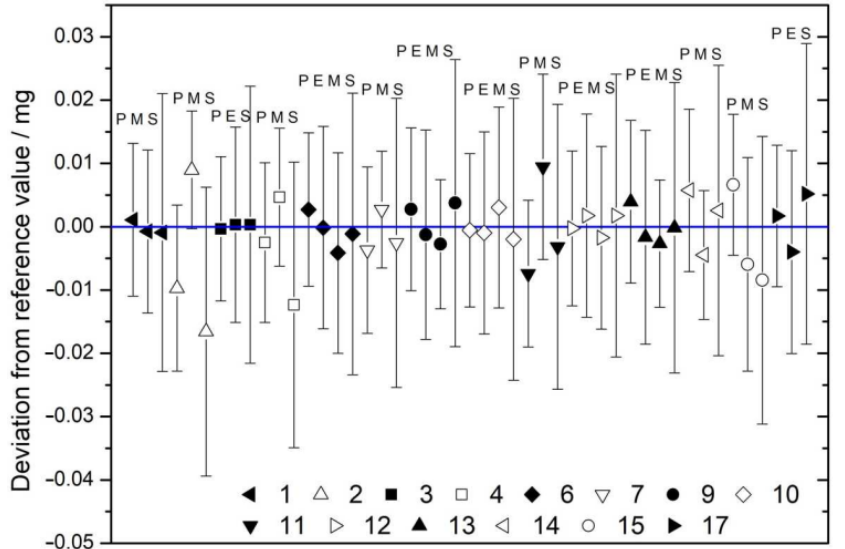
Figure 19. Deviation from reference value (blue line) for pycnometer and substitution reduced mass uncertainties.